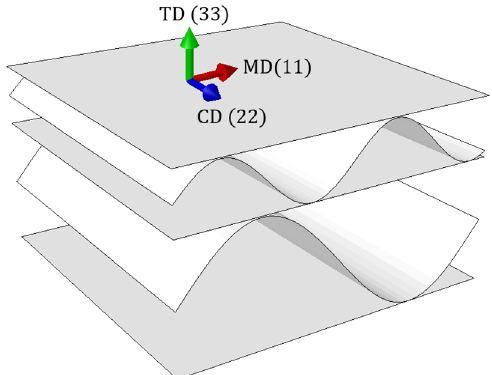
Figure 1. Material orientation. Machine direction (MD), cross direction (CD), and thickness direction (TD). The notation 1, 2, 3 refers to the principal orthotropic directions.